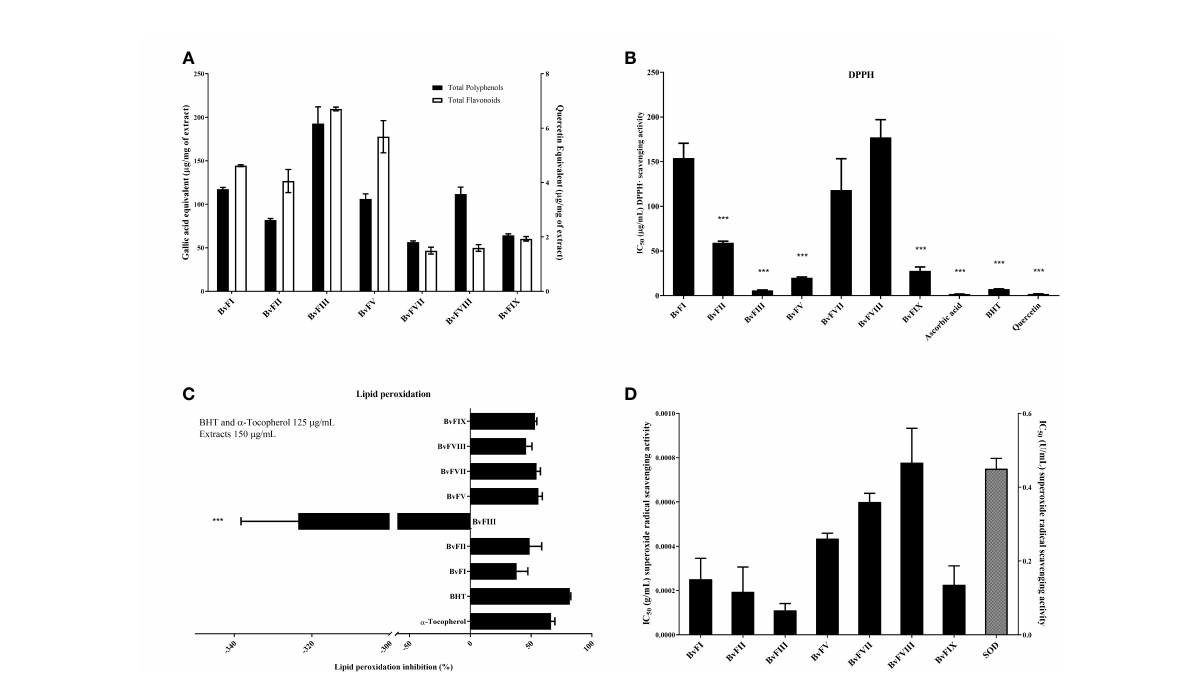
FIGURE 2 Polyphenols and fl avonoids content and antioxidant effects. (A) Polyphenols and fl avonoids contents in the extracts produced by the endophytic fungi isolated from Bauhinia variegata leaves. (B) Hydrogen-donating ability of the fungi extracts (BvFI, BvFII, BvFIII, BvFV, BvFVII, BvFVIII, and BvFIX) was evaluated by the DPPH· method. The concentration range of the extracts used in the reaction medium was 0.036 to 150.6 µg.mL -1 . Standard compounds, ascorbic acid, BHT, and quercetin concentrations in the reaction medium also were used in the same concentrations. (C) Evaluation of the ability to inhibit lipid peroxidation by extracts of fungi. The emulsion of linoleic acid with polysorbate 20 in the presence and absence of extracts (150 µg.mL -1 ) and standards with the antioxidant activity known [tocopherol (125 µg.mL -1 ) and BHT (125 µg.mL -1 )]. (D) Endophytic fungi extract ability to scavenge superoxide anion radicals. Extracts ’ ability in scavenge superoxide anion radicals was evaluated using the xanthine/xanthine oxidase system as the source of the superoxide. O − 2 · produced reduces NBT to formazan detected by spectrophotometry at 560 nm. Antioxidants scavenge superoxide anion radicals, decreasing the reduction of NBT and, consequently, formazan production. Results were expressed as the percentage of inhibition of the lipid peroxidation process, as mean ± standard deviation of three different assays. The statistical test applied was the analysis of variance (one-way ANOVA) followed by the Newman-Keuls multiple comparison test, ***, signi fi cantly different, p<0.0001 vs. all